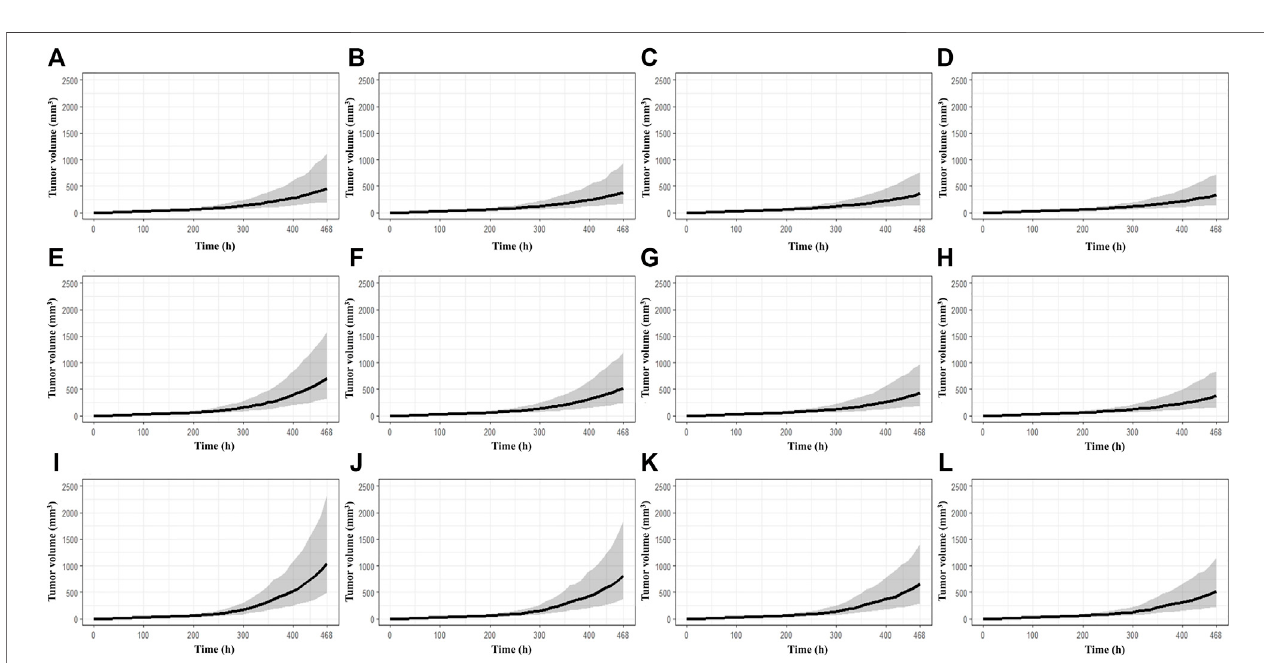
FIGURE4| Multiple-dosesimulationstudy. (A) BoNT/A16 Ukg − 1 forQ.D. (B) BoNT/A113.8 Ukg − 1 forQ.D. (C) BoNT/A131.7 Ukg − 1 forQ.D. (D) BoNT/A174 U kg − 1 for Q.D. (E) BoNT/A1 6 U kg − 1 for Q.3.D. (F) BoNT/A1 13.8 U kg − 1 for Q.3.D. (G) BoNT/A1 31.7 U kg − 1 for Q.3.D. (H) BoNT/A1 74 U kg − 1 for Q.3.D. (I)